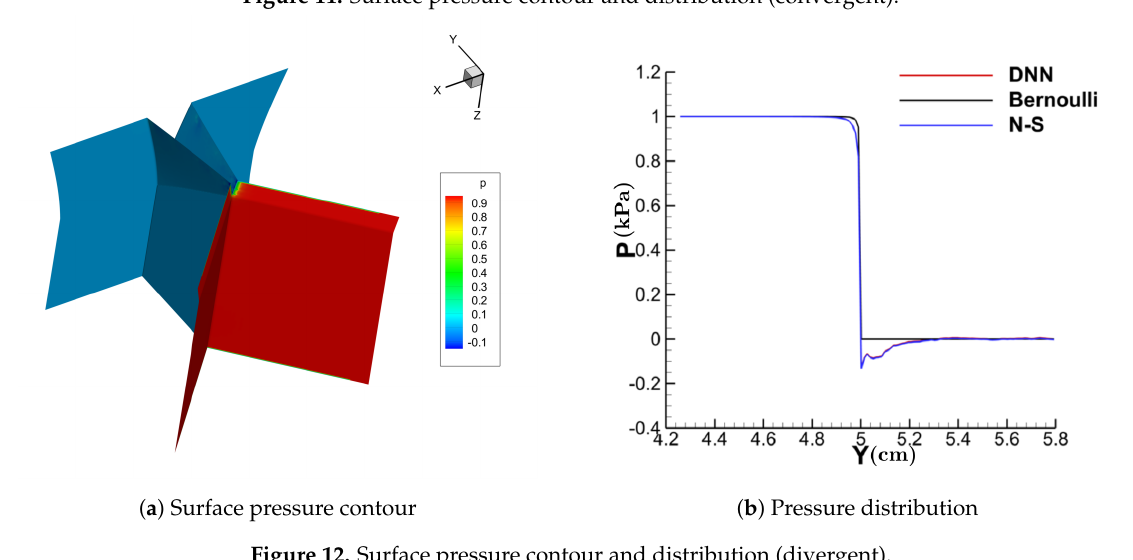
Figure 11. Surface pressure contour and distribution (convergent).